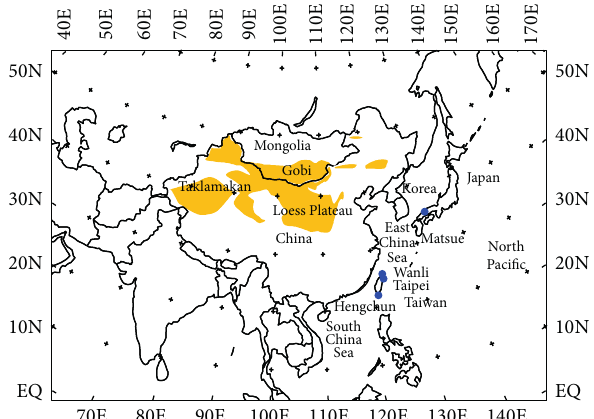
Figure 1: TAQM model domain and dust observation sites (blue dot) at Wanli, Taipei, and Hengchun in Taiwan and Matsue in Japan. Deserts over China are indicated by shaded